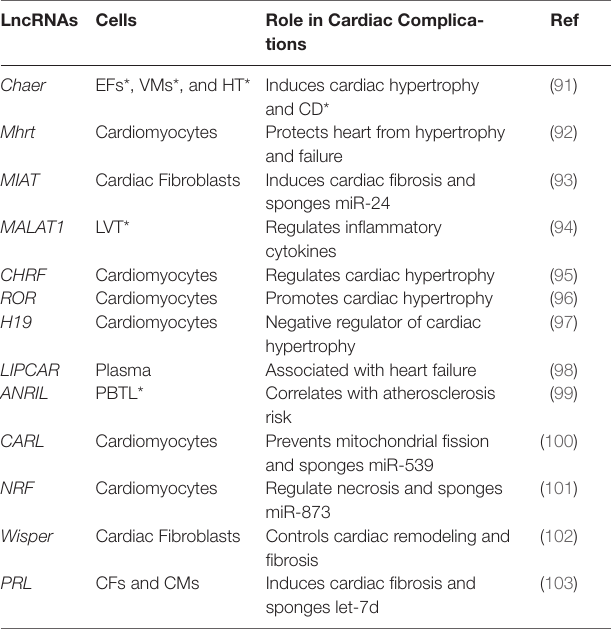
DNA Methylation TAbLe 1 | List of the prominent lncRNAs implicated in cardiac complications.